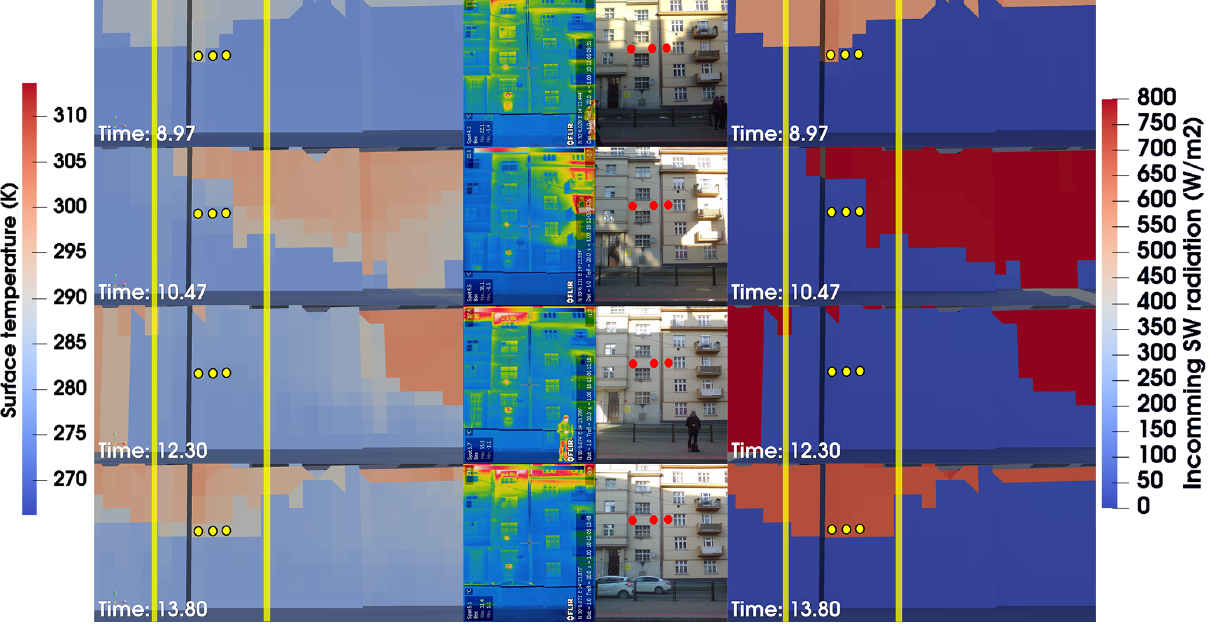
Figure 18. Observed camera photos (IR – centre left; RGB – centre right) on 5 December 2018 at observation times of 07:51, 09:26, 11:18, and 12:48UTC, and the modelled counterparts for the closest saved model time step: surface temperature (left) and incoming SW radiation (right). The yellow dots denote positions of evaluation points 1, 2, and 3 (Fig. 11), and the yellow lines show the extent of the area shown on the IR and RGB photos. For technical reasons, the step times for the model views express minutes as decimal fractions of the